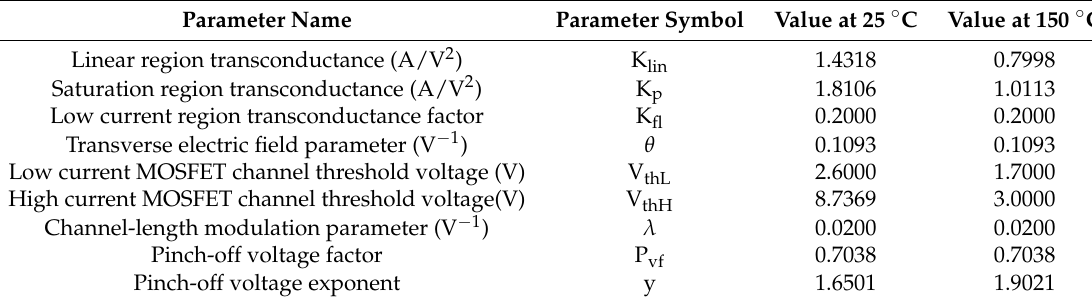
Table 1. MOSFET model